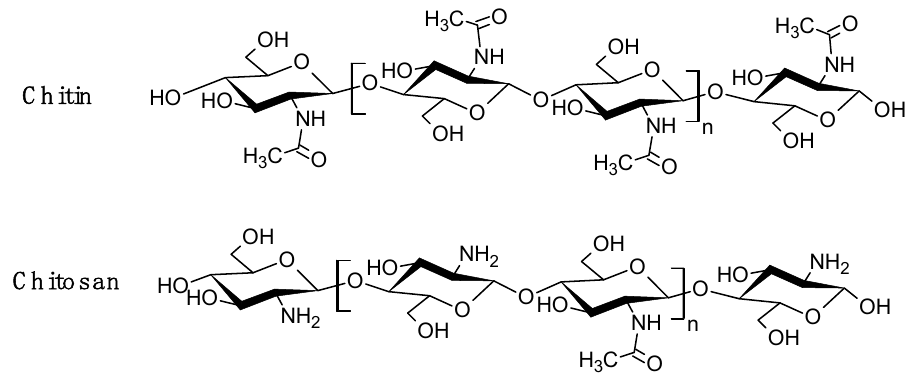
Figure 1. Chemical structure of chitin and chitosan.